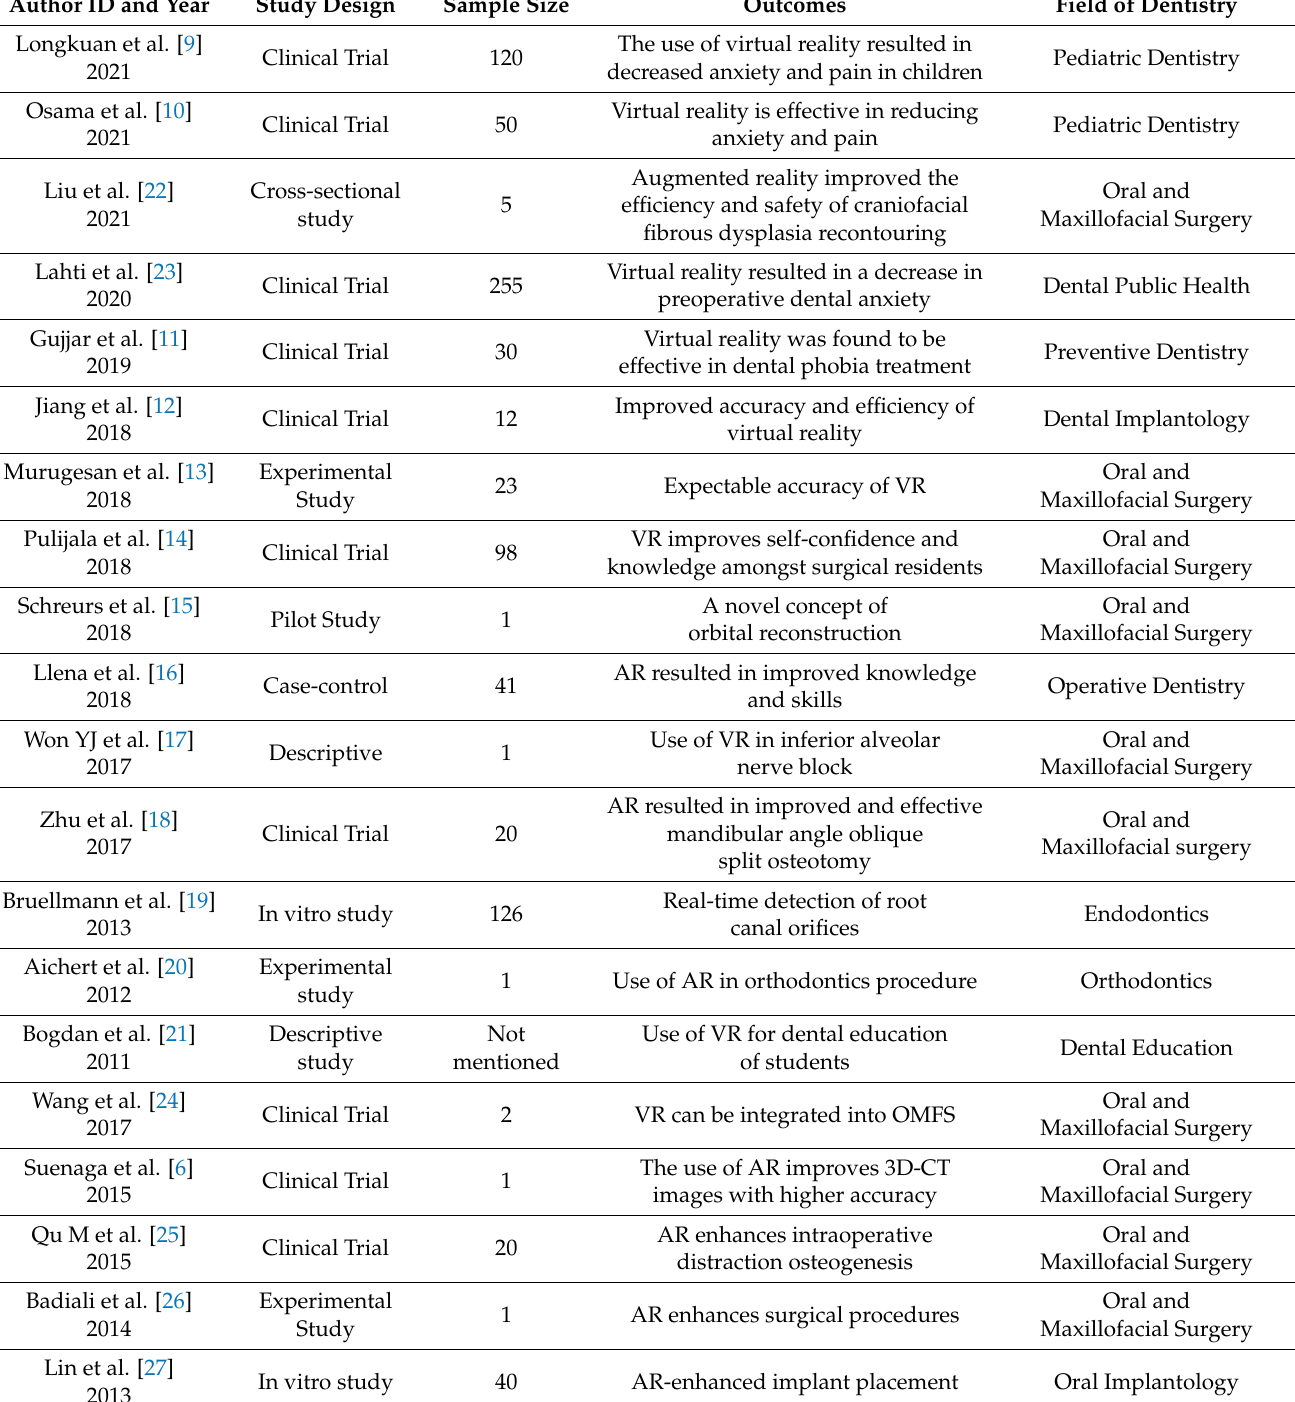
Table 1. Application of augmented reality and virtual reality in